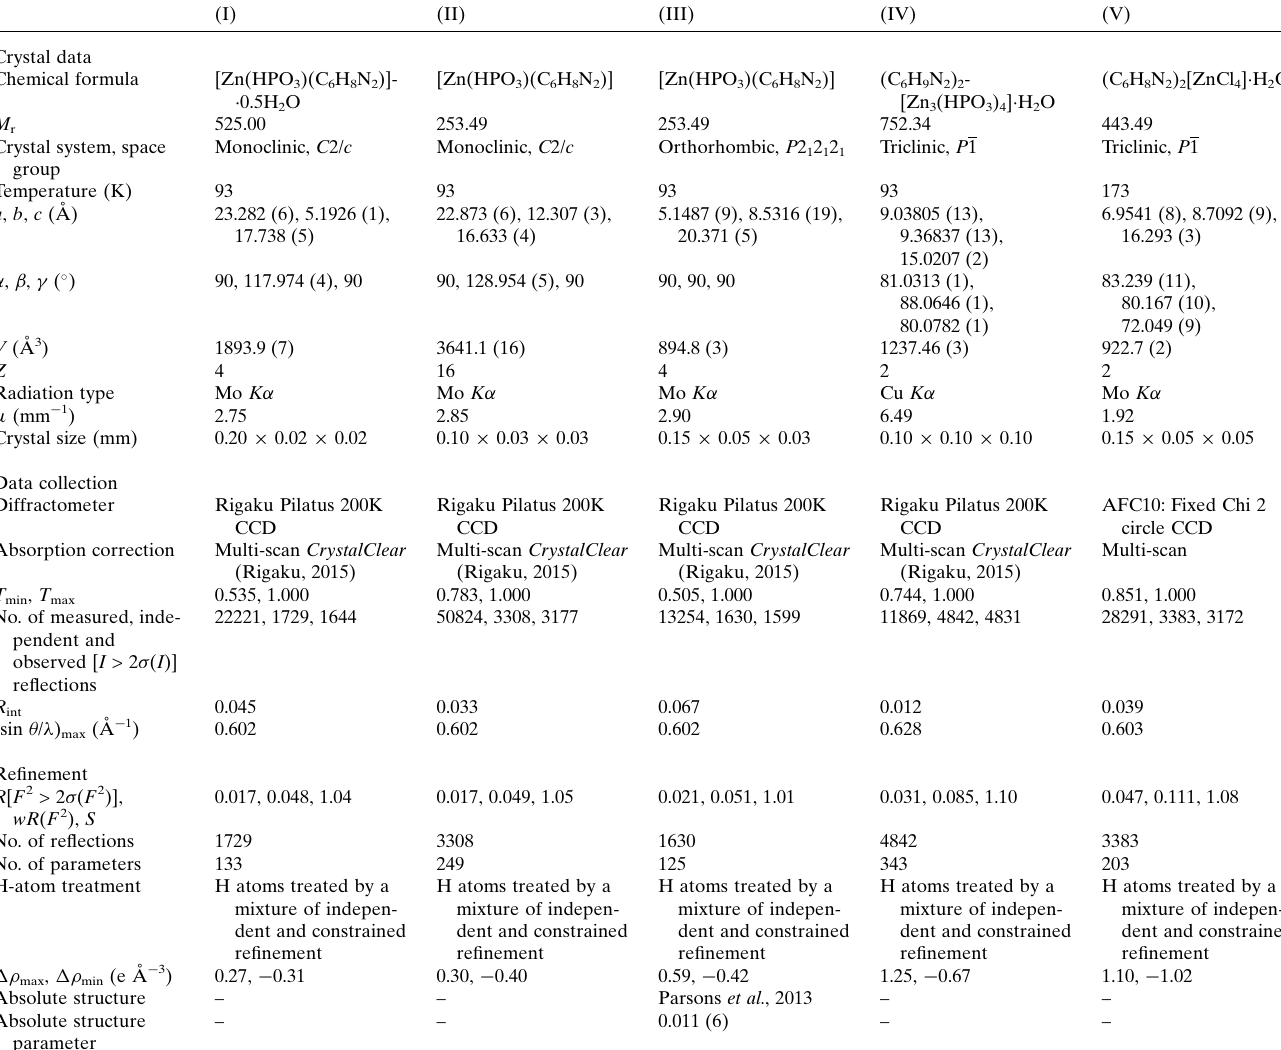
Table 6 Experimental